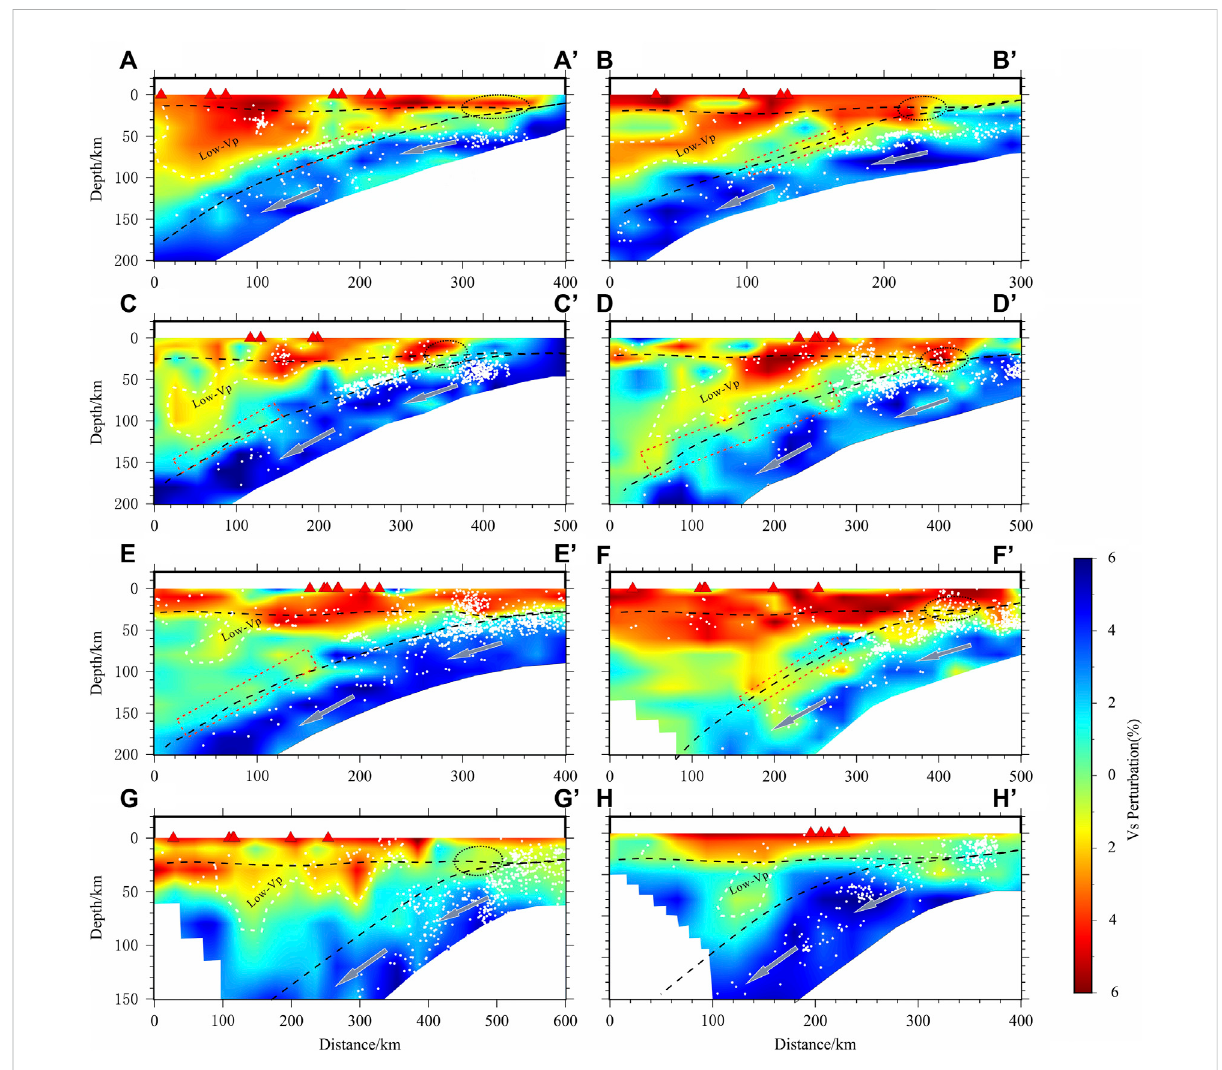
FIGURE 11 The same as Figure 10, but indicates S-wave velocity ( Vs